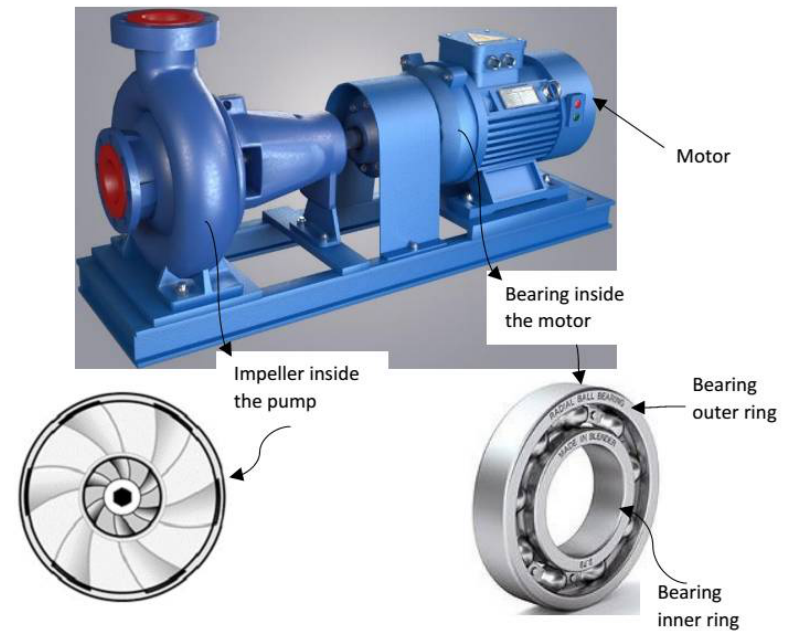
Figure 2. The important components of the centrifugal pump.